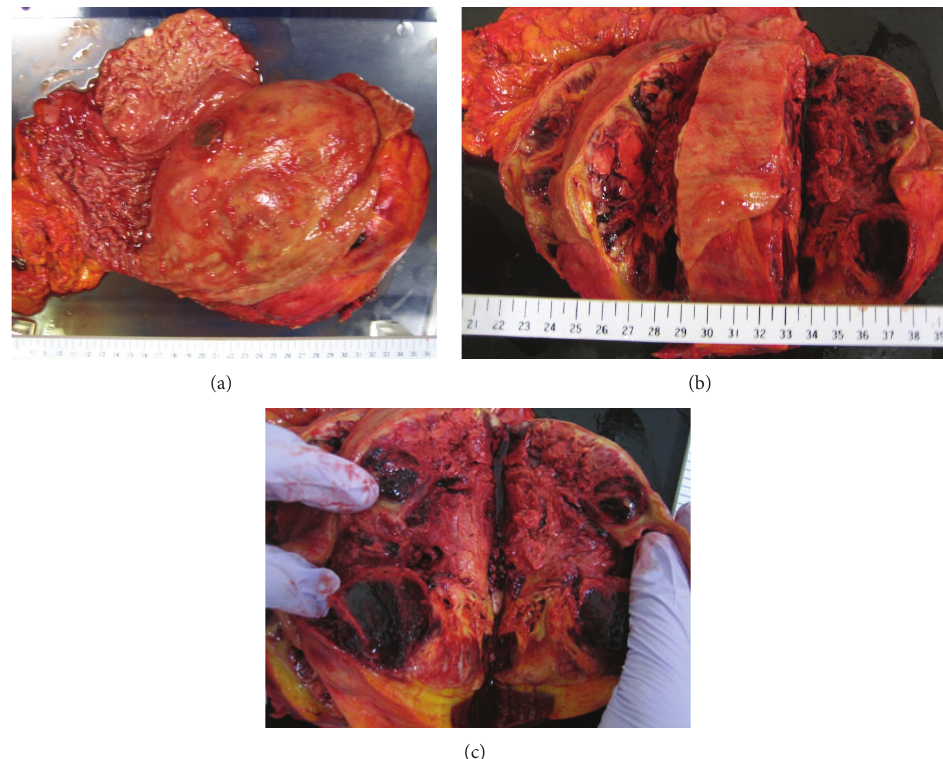
Figure 3: Resected specimen of the giant submucosal tumor-like mass in the stomach. The pathological specimen included the stomach, spleen, part of the pancreas tail, and disseminated lesions. The cut surface of specimen showed necrosis and hemorrhage. On gross examination, the body of the stomach revealed a protruding tumor covered with mucosa and measuring 20 × 18 × 11cm in